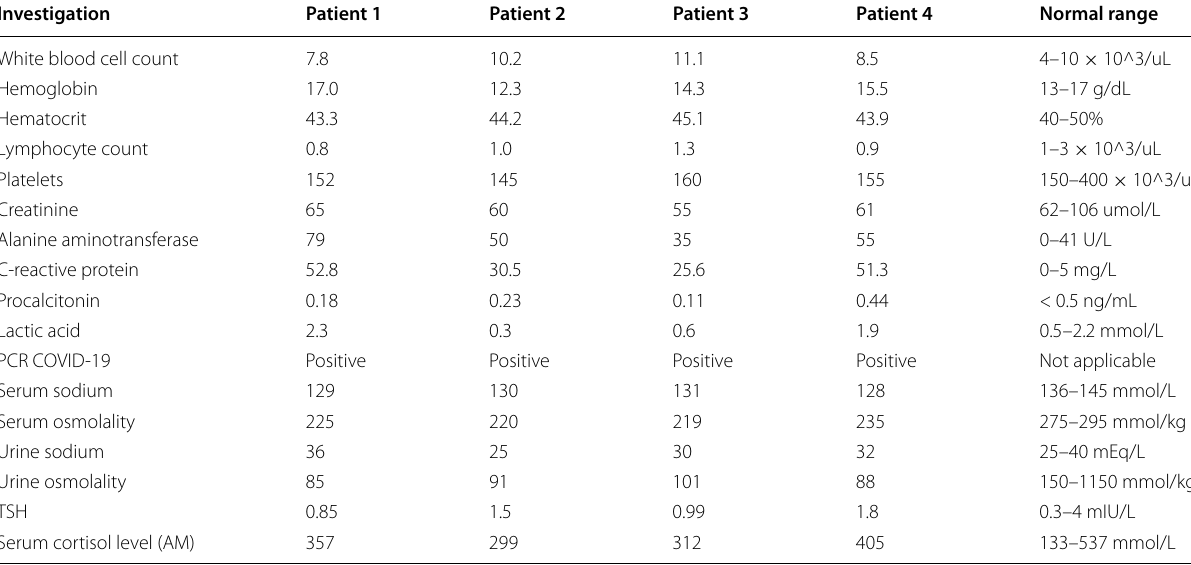
Table 1 Laboratory investigations for COVID‑19 patients with hyponatremia